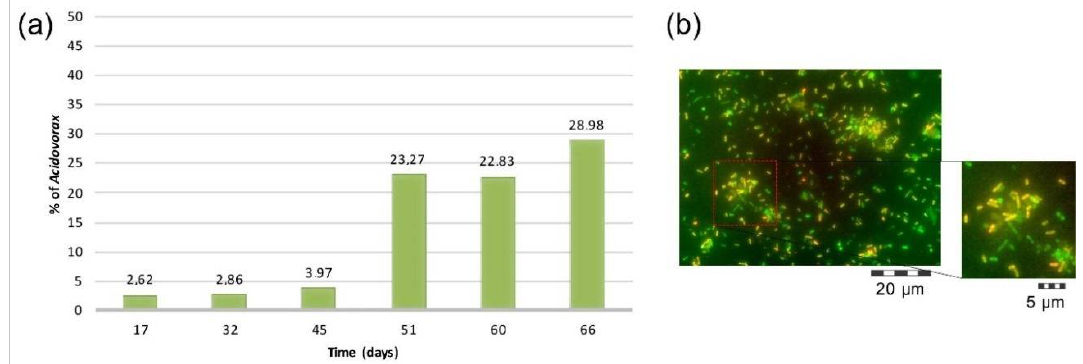
Figure 7. ( a ) Acidovorax content evolution throughout the reactor operation. Percentages based on the relative abundance of Betaproteobacteria. ( b ) FISH picture of Acidovorax on day 66. Green cells are hybridized with EUBmix and the yellow cells also hybridized with ACI145 probe.